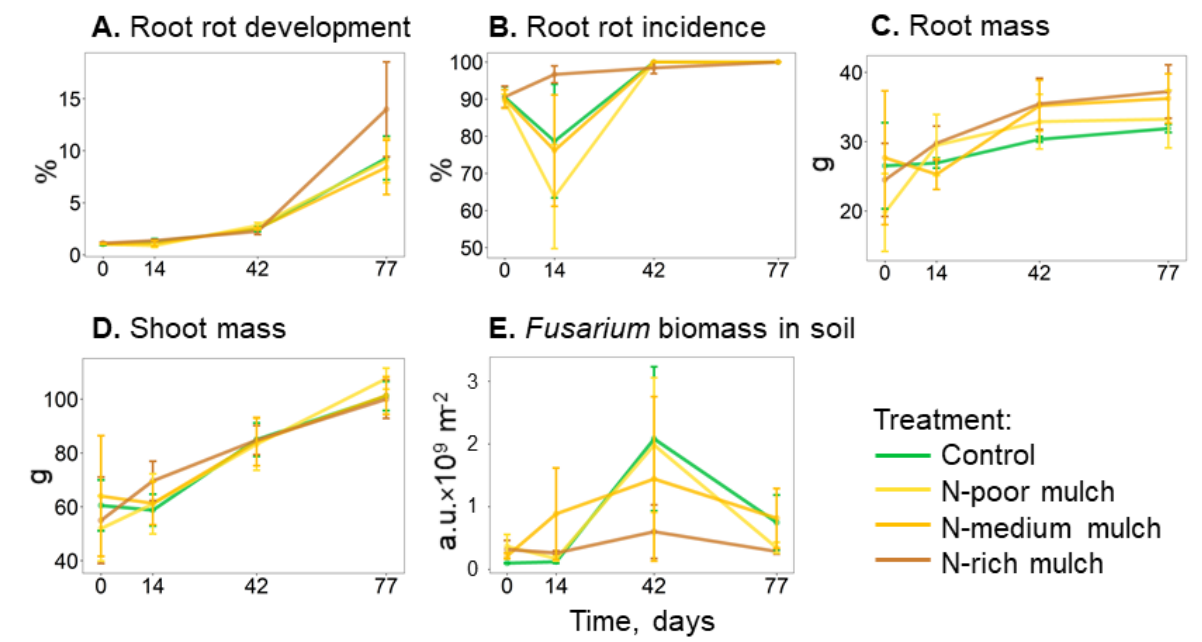
Figure 2. Dynamics of ( A ) root rot development, ( B ) root rot incidence, ( C ) root mass, ( D ) shoot mass, and ( E ) Fusarium biomass in soil, in the control (green lines), N-poor mulch (yellow lines), N-medium mulch (orange lines), and N-rich mulch (brown lines) treatments. Mean ± 1 S.E., n = 5. Table 2. Integral mean values and results of statistical comparison of measurements from experi- mental treatments. Different letters represent a significant difference between treatments (Kruskal- Wallis test and Dunn test, p < 0.05). No significant difference between treatments is denoted as “n.s.”.